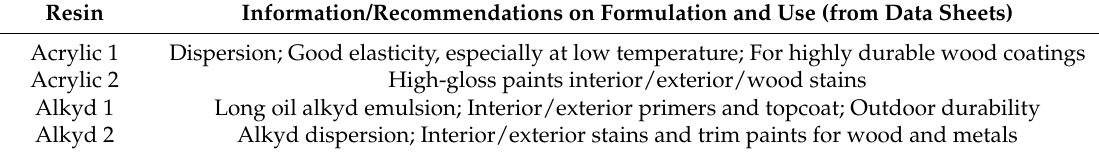
Table 1. Description of the four resins used.